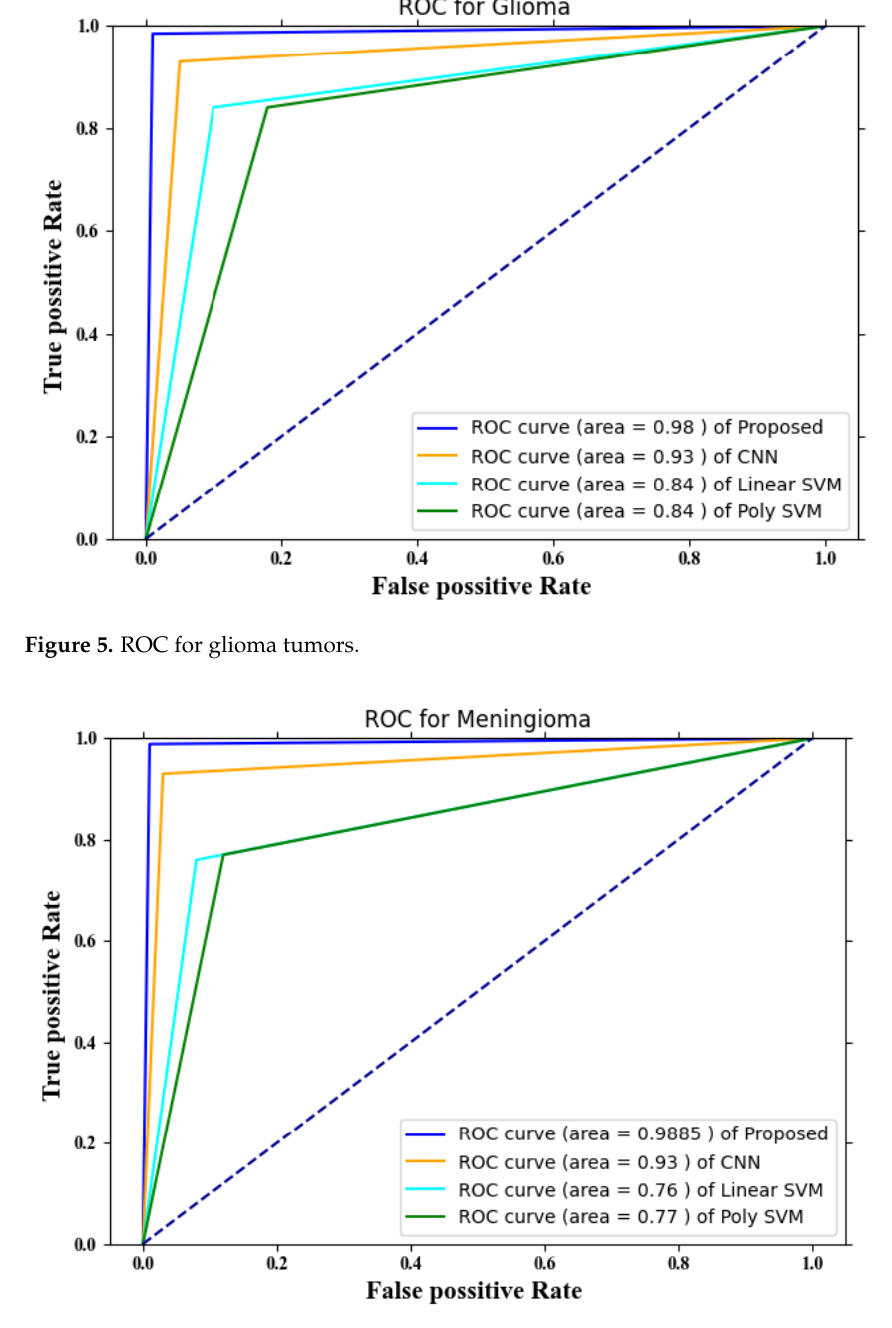
Figure 6. ROC for Figure 6. ROC for meningioma.